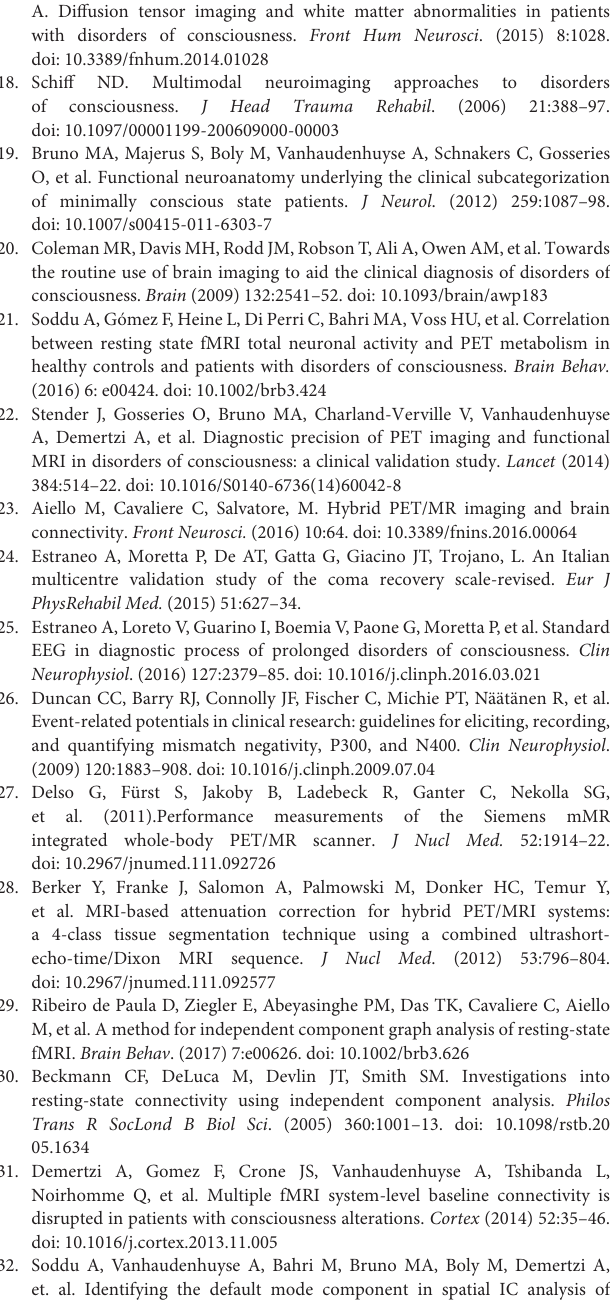
Figure S3 | Three most representative axial slices of the GS implemented on the normalized structure of the DMN network are presented for the three patients for the best functional pattern and concatenated data. Figure S4 | Scatter plots for the EMCS, MCS and patients in UWS showing the correlation between the FDG-PET and GS of the 1015 parcellated ROI. Solid line indicates the best linear fit to the data and on the northeast corner of each scatter plot the linear correlation value is reported along with its statistical p -value.